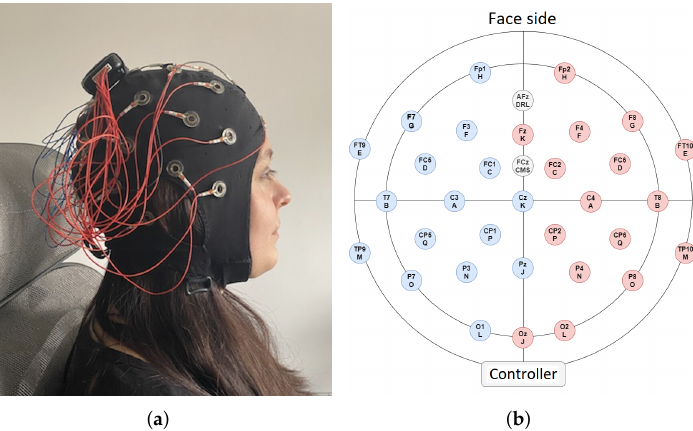
Figure 6. The EMOTIV EPOC Flex: ( a ) a subject in EEG head cap system; ( b ) electrode